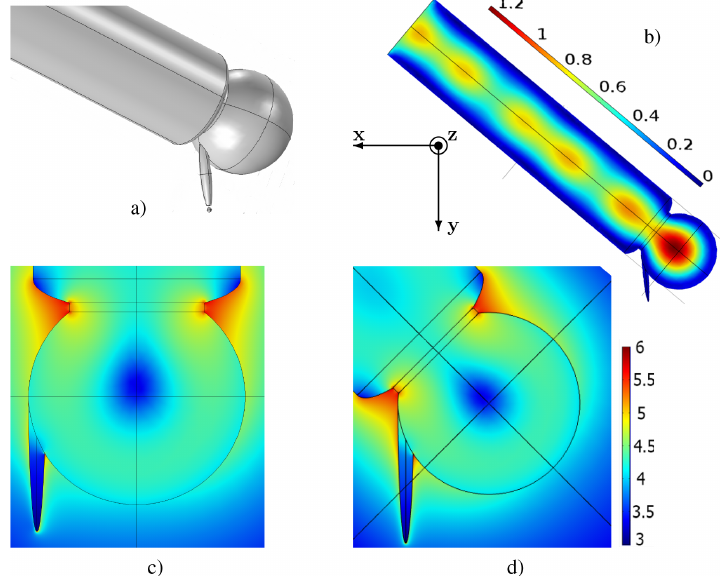
Figure 32. ( a ) scheme of a LFDT; ( b ) numerical simulations of the magnetic field | H | . Excitation